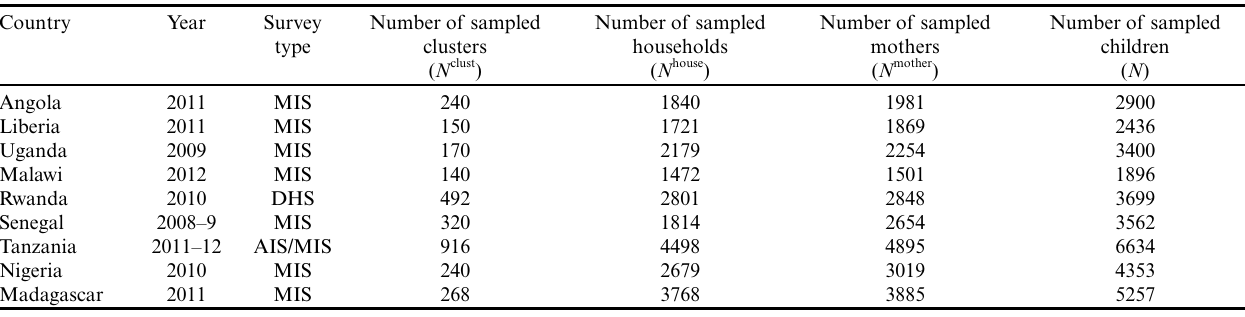
Table 1 . Household-level Demographic and Health Surveys (DHS)/Malaria Indicator Surveys (MIS) used in analyses, and sample size (AIS: AIDS Indicator Survey).